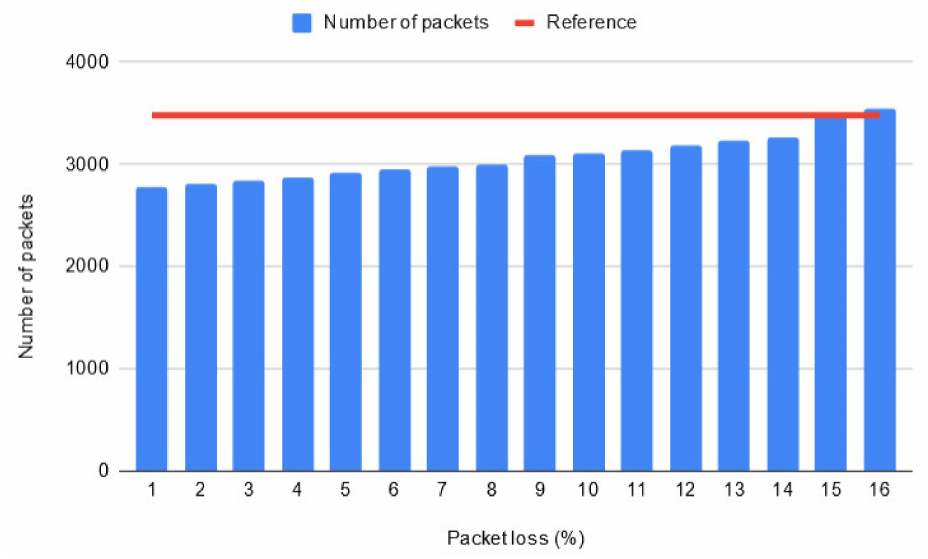
Figure 14. Statistics for the scenarios with packet